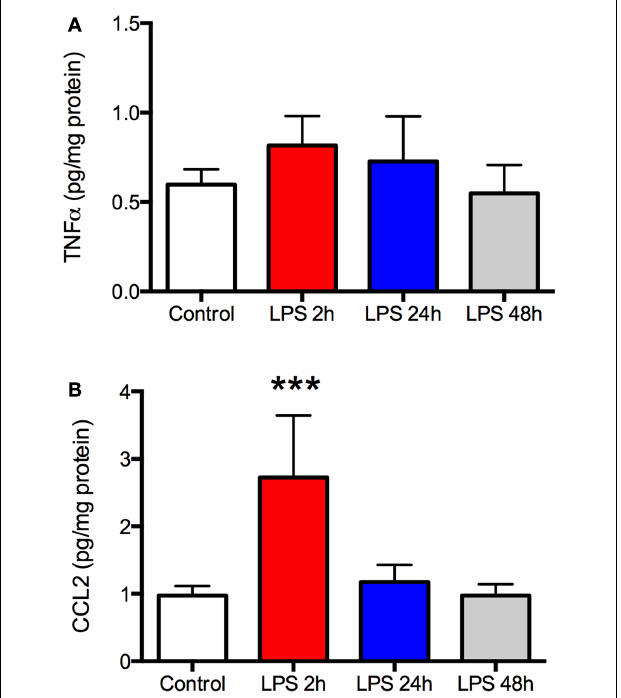
FIGURE 2 | Lipopolysaccharide (LPS) produces a robust but transient increase inTNF α and CCL2 in the frontal cortex . Rats ( N = 5 per group) were treated as described in Figure 1 and frontal cortex harvested at the time of sacrifice.There was no change inTNF α in the frontal cortex at any time compared to control animals (A) . CCL2 was elevated nearly threefold above control 2h after LPS but this resolved by 24h after treatment (B) . Data are mean ± SEM. *** P < 0.001 by one-way